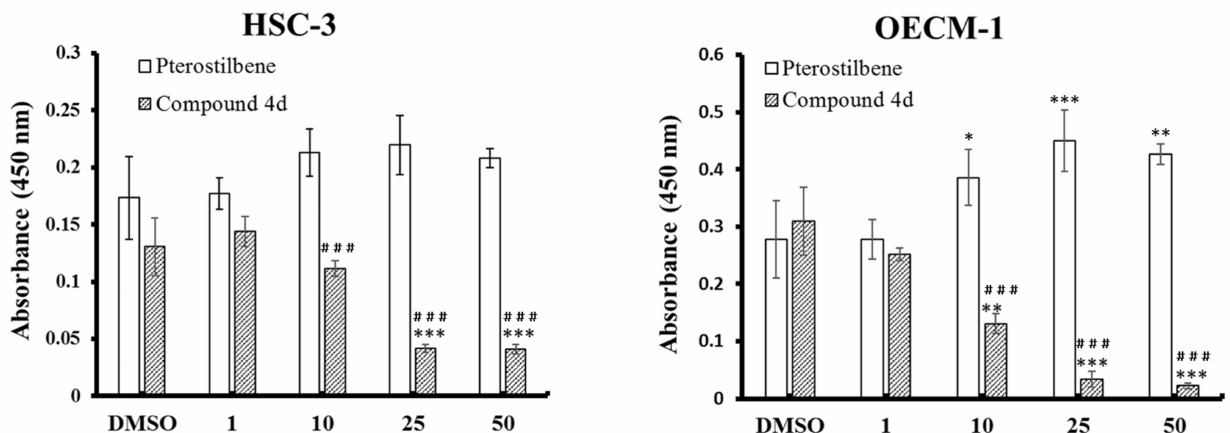
Figure 3. Inhibition of cell proliferation by compound 4d . For cell proliferation analysis, HSC-3 and OECM-1 cells were treated by compound 4d or pterostilbene with 0 (DMSO control), 1, 10, 25, and 50 µ M for 24 h followed by BrdU incorporation assay. Incorporated BrdU in cells was determined by measurement of 450 nm absorbance using a spectrophotometer. The data is presented as the mean ± standard deviation of three independent experiments. Statistically significant differences of OD450 are indicated as follows: * p < 0.05, ** p < 0.01, *** p < 0.001 between each group and vehicle control; ### p < 0.001 between compound 4d treatment and the same concentration of pterostilbene